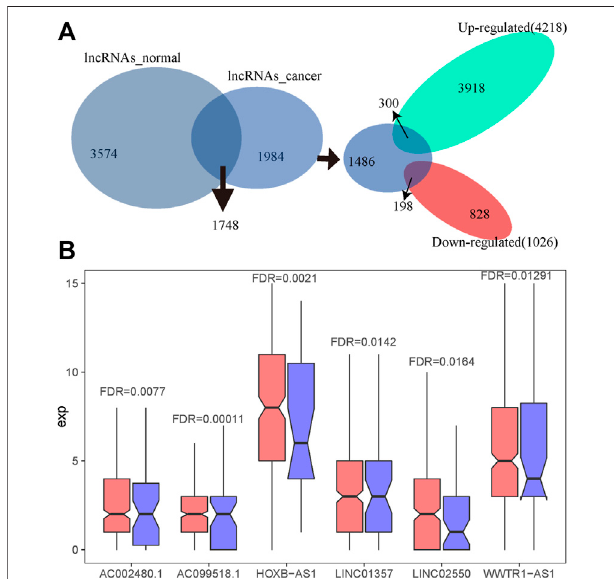
FIGURE 4 | The identi fi cation of candidate aberrant immune lncRNAs speci fi c to HCC. (A) Intersection of differentially expressed lncRNAs and lncRNAs of cancer-speci fi c lncRNA – immune function pathway pairs. (B) The expression of lncRNAs in HCC and normal tissues, in which red represents the expression distribution of lncRNAs in cancer and blue represents the expression distribution of lncRNAs in normal samples.